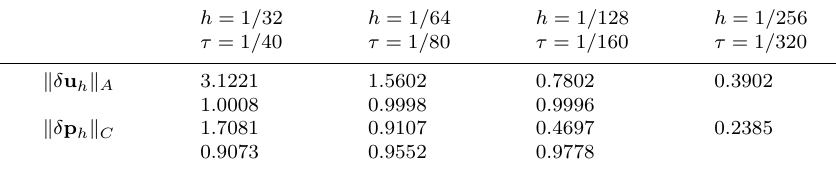
Table 2. Energy norms of the errors and orders of convergence.